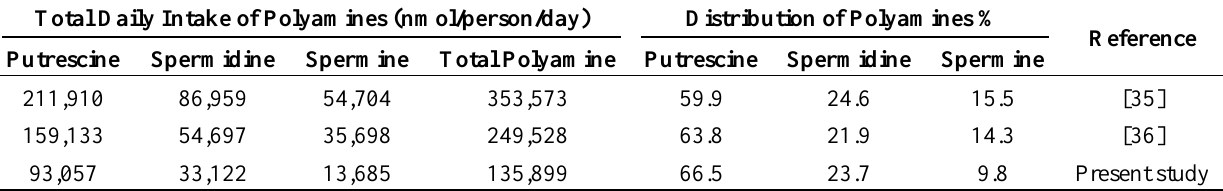
Table 3. Total daily intake and percentage distribution of